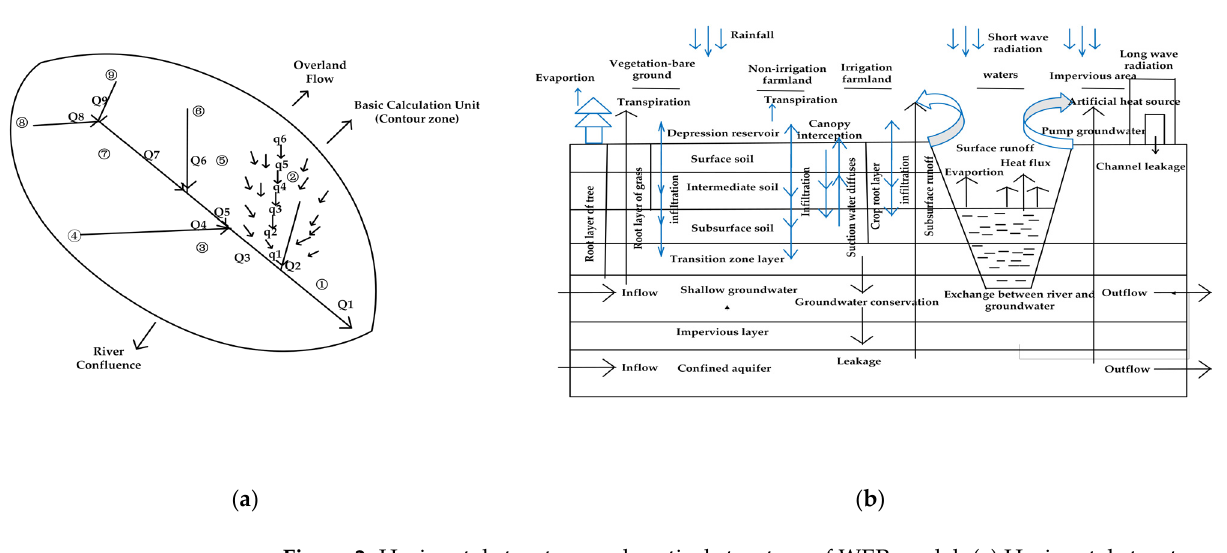
Figure 2. Horizontal structure and vertical structure of WEP model: ( a ) Horizontal structure—the basic calculation unit is “isometric zone in sub-basin”; ( b ) vertical structure—this is divided into nine layers (from top to bottom: Vegetation canopy, surface depression reservoir, the surface soil, the soil in the middle, the underlying soil, transition layer, shallow groundwater layer, difficult permeable layer, and confined aquifer).